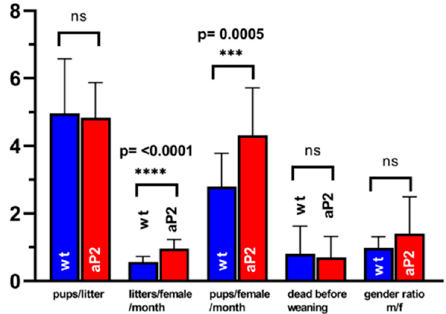
Figure 7. Reproduction statistics of aP2-ALOX15 mice and corresponding wildtype controls. 19 breeding pairs (two female individuals plus one male individual) of aP2-ALOX15 mice and of wildtype control animals (C57BL6) were established and kept together for 4–6 months. Litter size (pups per litter), frequency of pregnancy (litters per female and month), reproduction efficiency (pups per female and month), newborn survival rate (death before weaning), and gender ratio (males/females) were determined as readout parameters to compare the reproduction kinetics of the genetically modified aP2-ALOX15 mice with wildtype control animals. ns, statistically not significant, *** statistically significant with p < 0.001, **** statistically significant with p < 0.0001